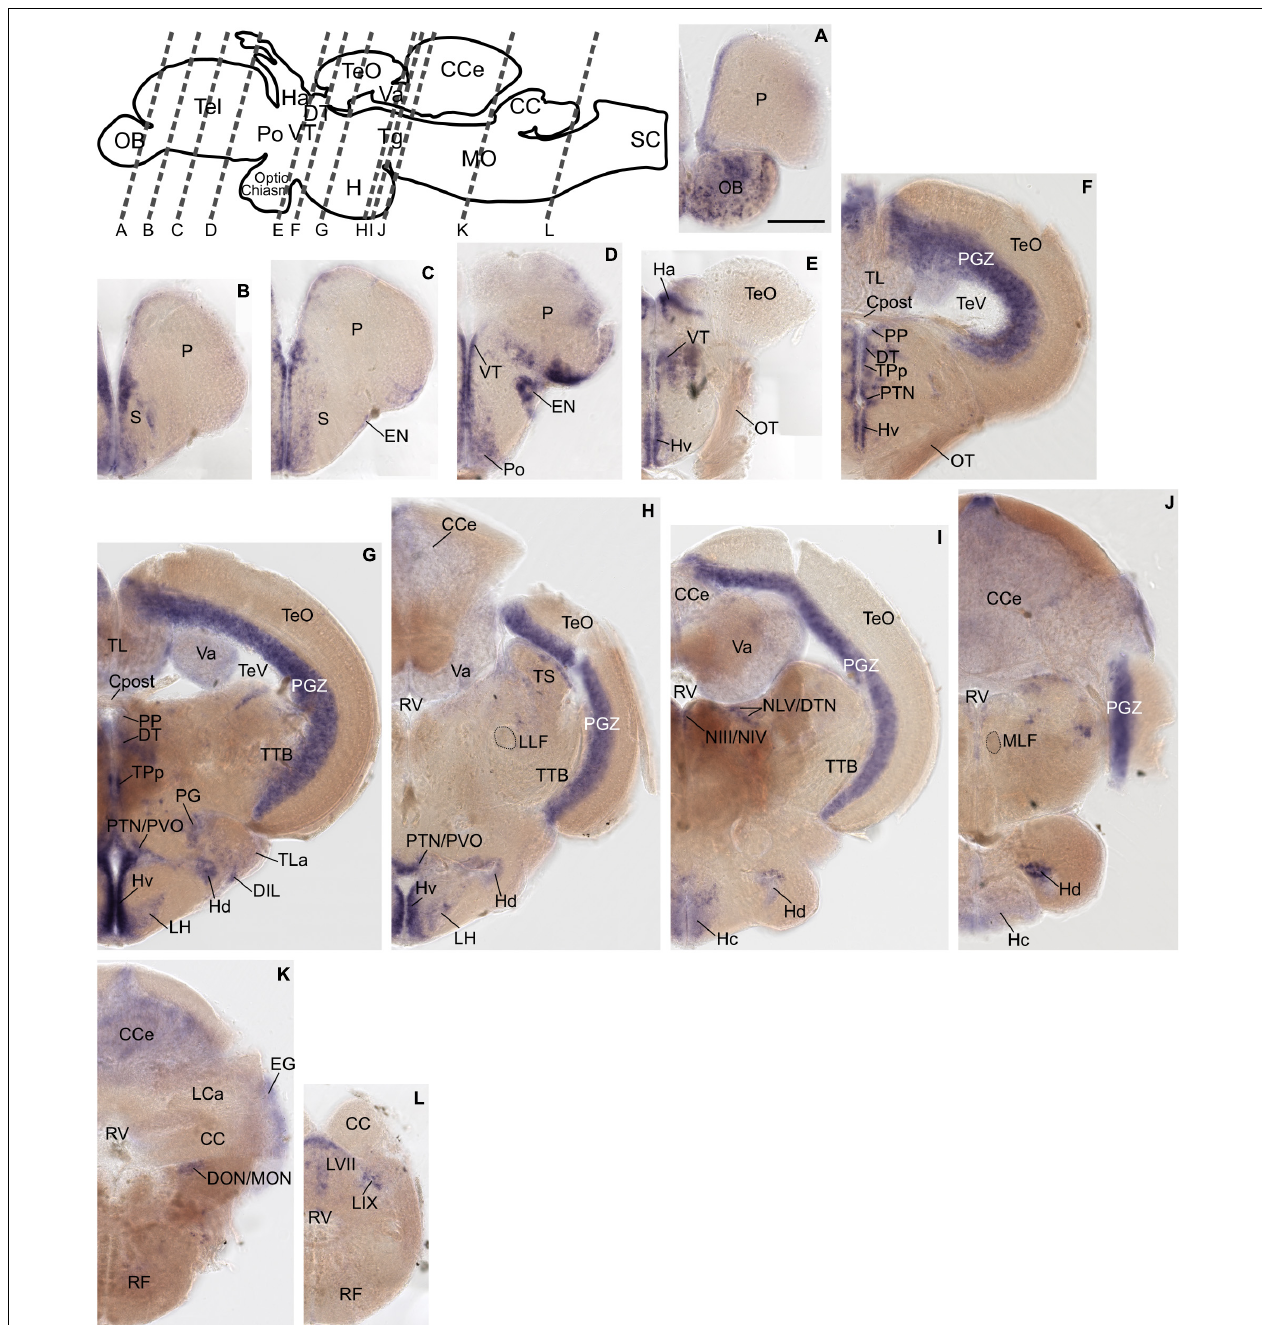
FIGURE 3 | Grm8b expression pattern in adult zebrafish brain labeled by RNA in situ hybridization. (A–L) Grm8b transcript labeling by RNA in situ hybridization on cross-sections of an adult zebrafish brain. Images are arranged from anterior to posterior as indicated by the scheme at the top. Details on grm8b expression pattern are described in the main text. Anatomical abbreviations are listed in Table 1 . Scale bar is 200 µ